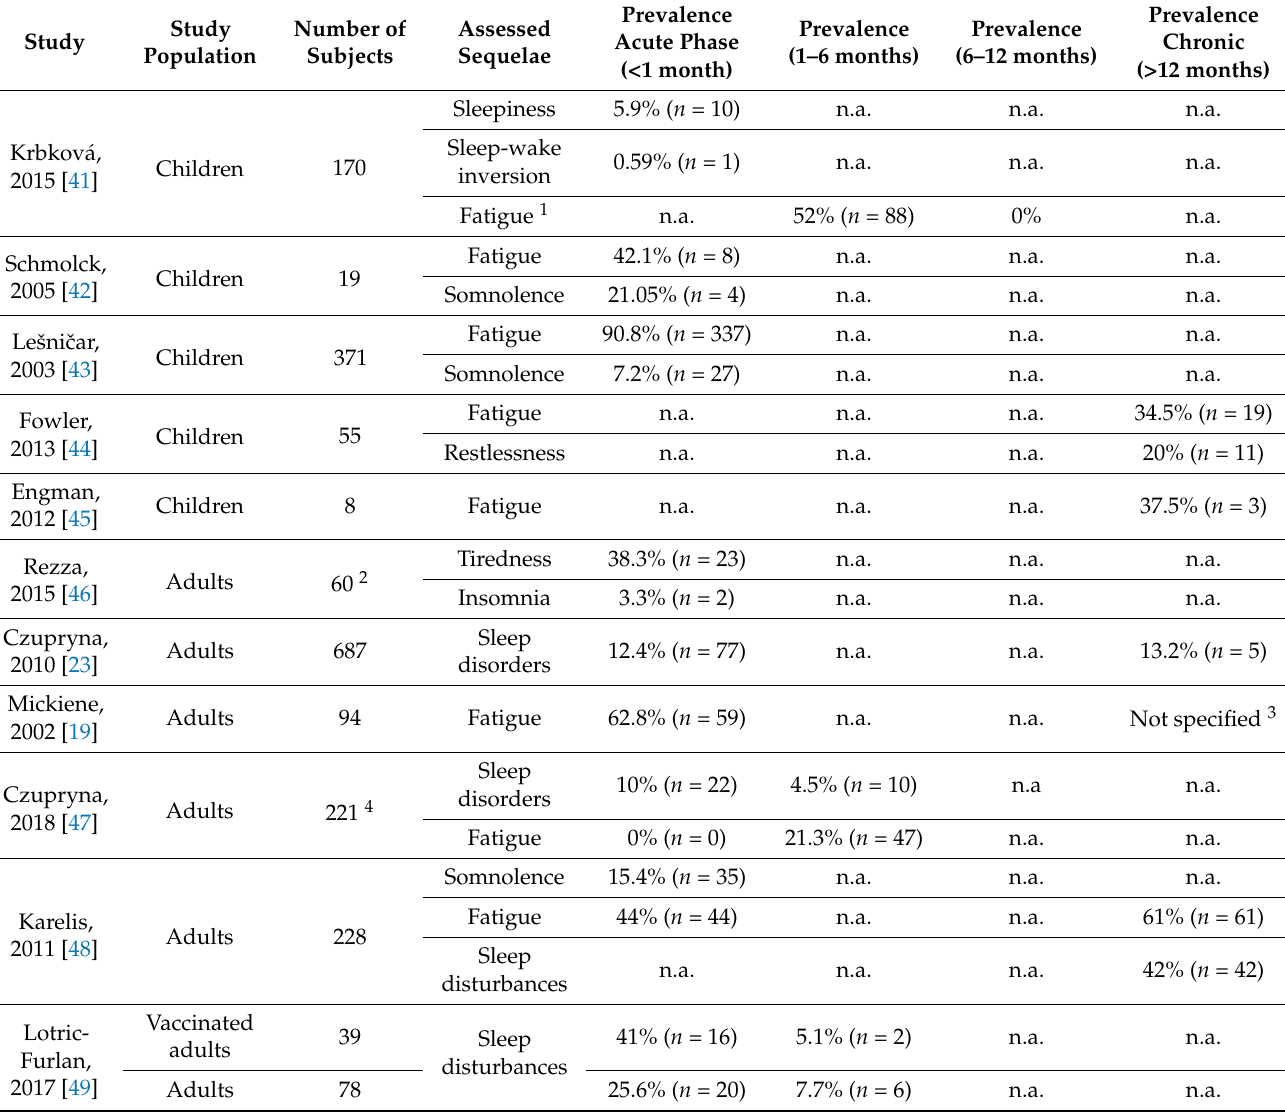
Table 2. Studies included in the review reporting the presence of sleep-wake and circadian disorders after TBEV in children and